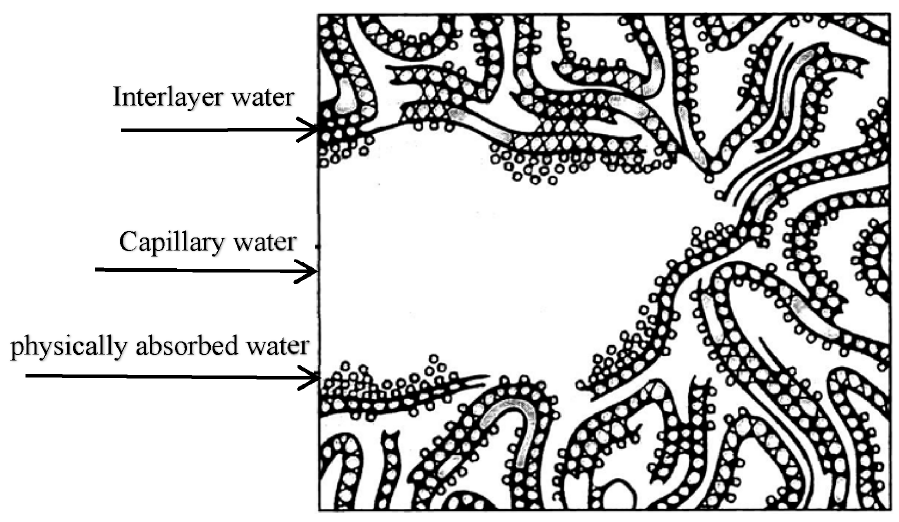
Figure 12. Water type in concrete materials.